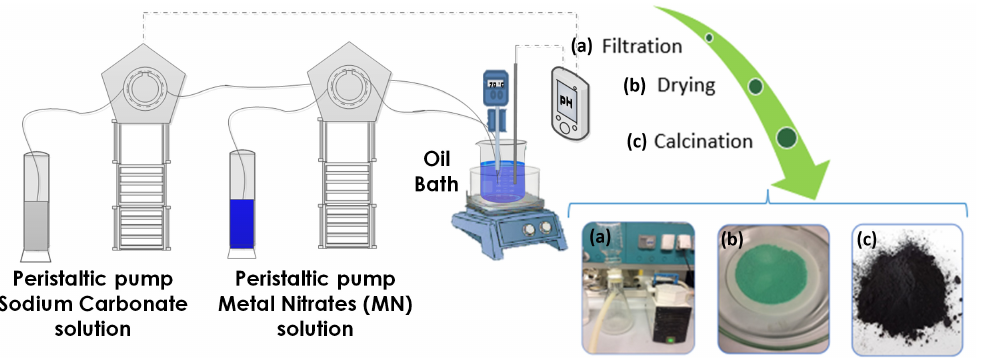
Figure 1. Synthesis process setup.